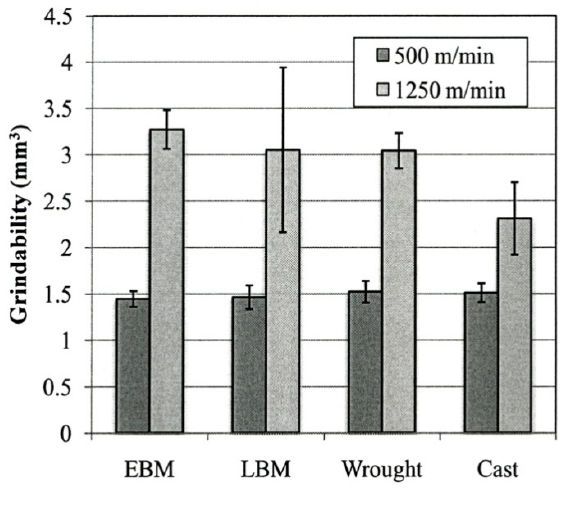
Figure 15. Grindability of Ti-6Al-4V ELI specimens using different fabrication